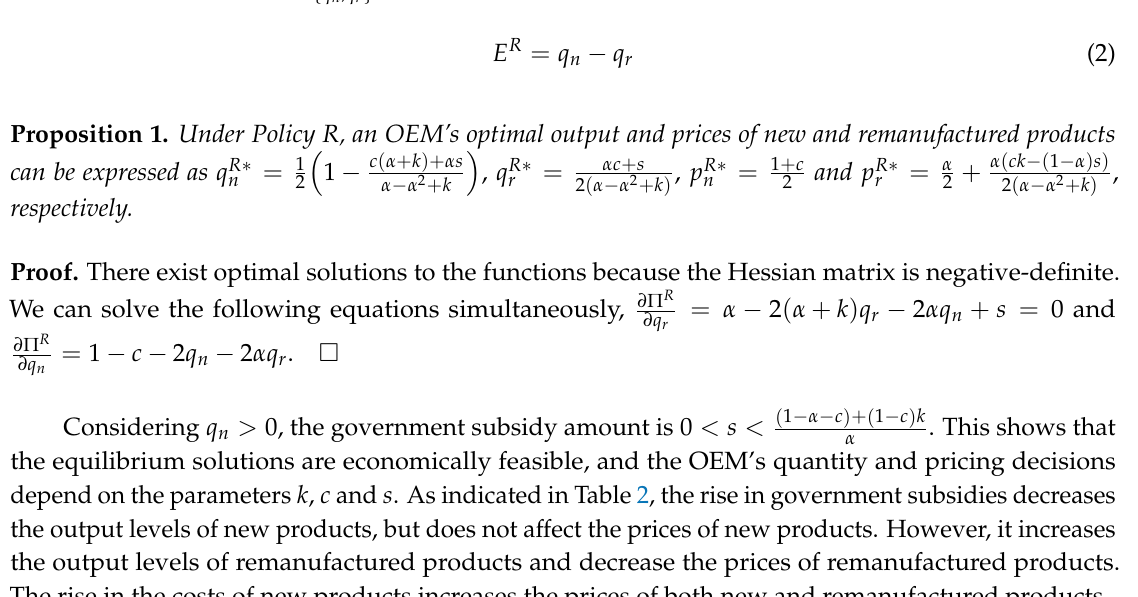
Table 2. Influence of Various Parameters under Policy R on the OEM’s Output and Pricing Decisions. Variable q R ∗ Parameter